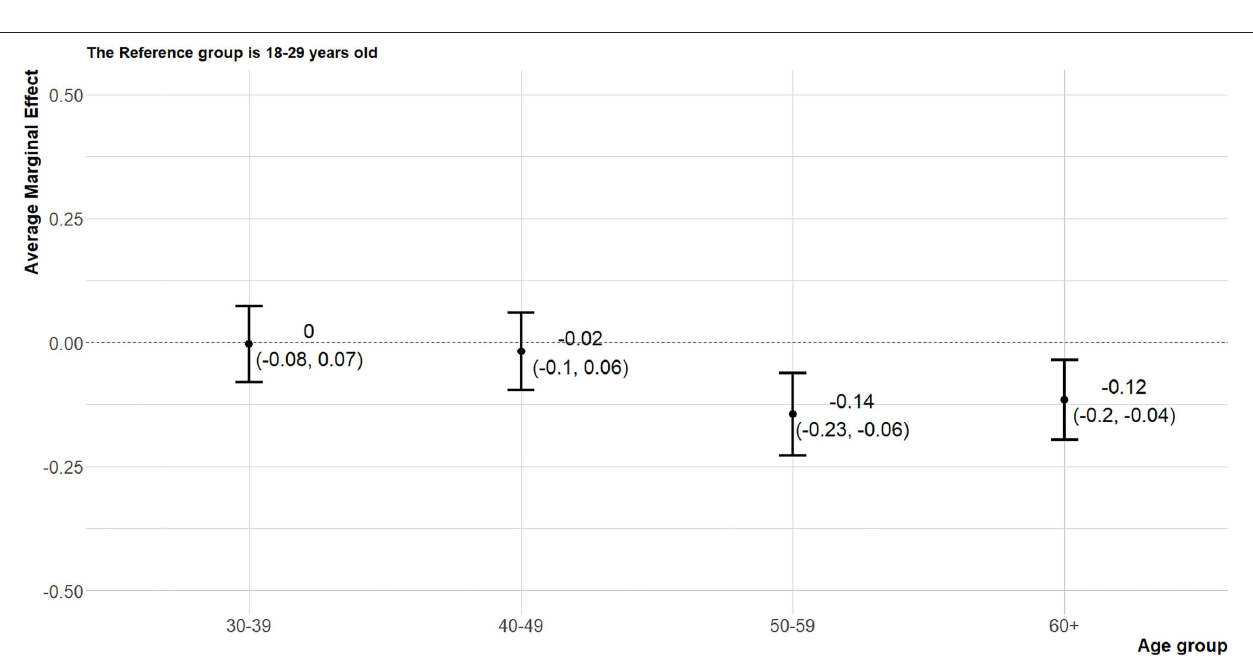
FIGURE 3 | The average marginal effects of age on attitude toward the cash transfer policy. The reference group is 18–29 years old.